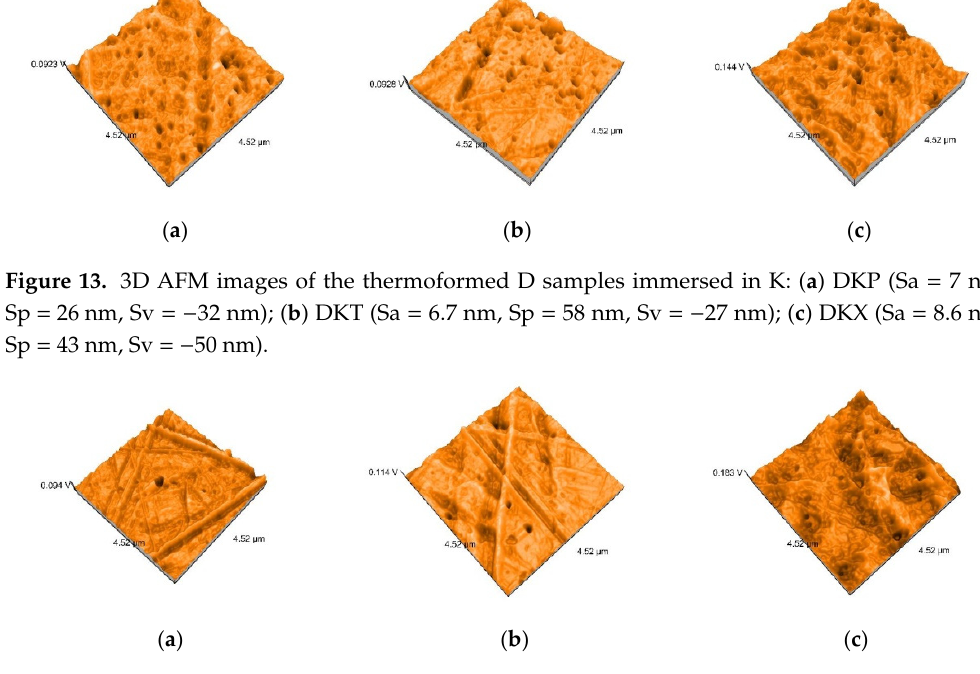
Figure 14. 3D AFM images of the thermoformed B samples immersed in W: ( a ) DKP BWP (Sa = 23 nm, Sp = 52 nm, Sv = − 56 nm); ( b ) BWT (Sa = 48 nm, Sp = 110 nm, Sv = − 99 nm); ( c ) BWX (Sa = 15 nm, Sp = 63 nm, Sv = − 54 nm).